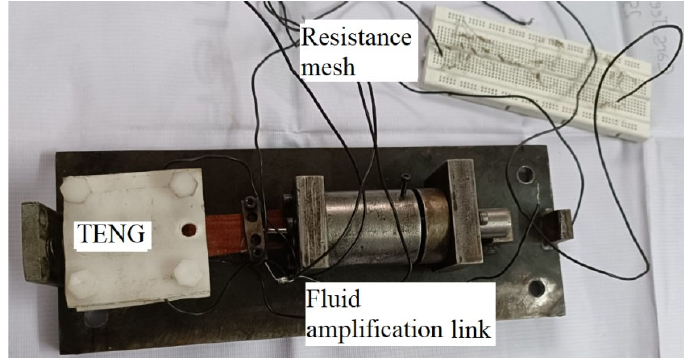
Figure 5. Photograph of the energy harvester.